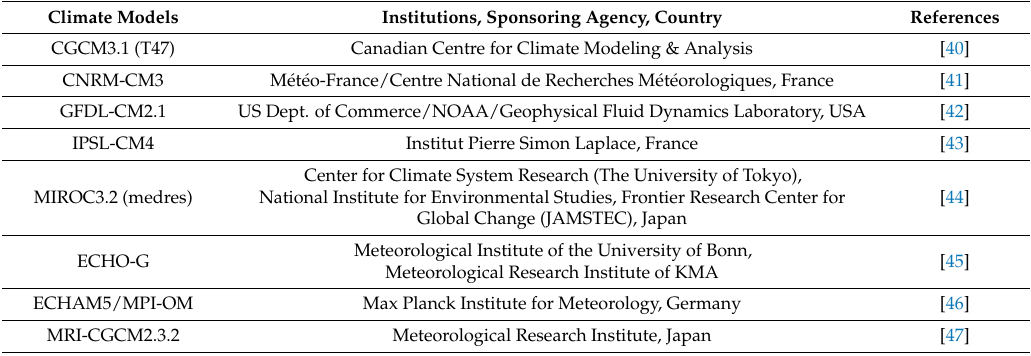
Table 1. The eight General Circulation Models (GCMs) that were used for precipitation and temperature